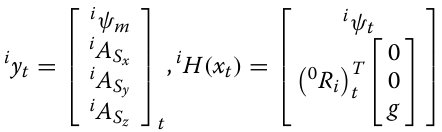
i ψ i θ In those equations, t , t respectively denote t , and Euler angles of the sensor placed on each lower limb segment, as estimated using the extended Kalman filter. i ω i ω Ts stands for the sampling time. In addition, x , t , v , t , i ω and z , t respectively denote the gyroscope outputs for i A i A i A the x , y , and z axes. Also, S x , S z respectively S y , and express the accelerometer output for the x , y , and z axes. i w i v Therein, t and t denote white noise. i ψ Yaw angle m , which was calculated using the mag- netometer output, and the accelerometer output were used as the observation values in Eq. (11). Equation (1) represents the relation between the accelerometer out- put and gravitational acceleration. Consequently, the i H right side of Eq. (1) was used in of the observa- tion equation. Although the proportion of the centrifugal acceleration and the tangential acceleration in the accel- erometer output would have increased during exercise, these acceleration components were processed as obser- i ψ i ψ vation noise. In addition, m = t is a simple equation representing the relation between the magnetometer out- put and the yaw angle of the state values. Therefore, the i ψ i H yaw angle of the t of the state value was used in observation equation. i The partial derivatives of